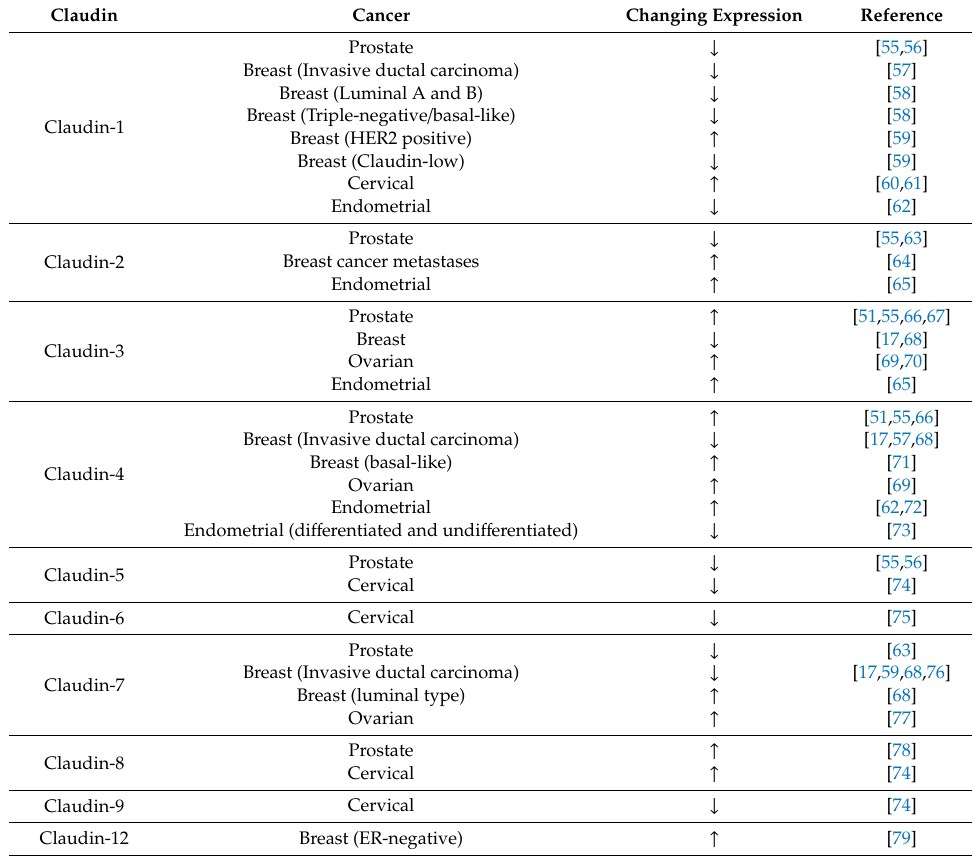
Table 2. Summarized changes in claudin expression in hormone-related cancers in the human reproductive system.